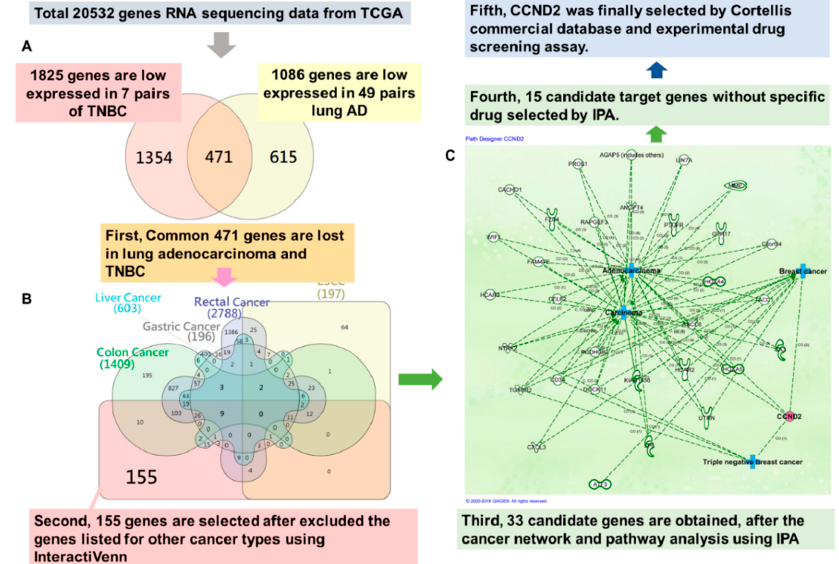
Figure 1. CCND2 is a common drug target for lung adenocarcinoma and triple-negative breast cancer. ( A ) The Venn diagram showed the number of intersections of lung adenocarcinoma (lung AD) and triple-negative breast cancer (TNBC). ( B ) The Venn diagram displayed the intersections among 7 types of cancer. ( C ) Thirty-three genes were involved in lung adenocarcinoma and triple-negative breast cancer, as analyzed using Ingenuity Pathway Analysis software. The red circle represents CCND2 protein. The blue cross represents the related tumor types.